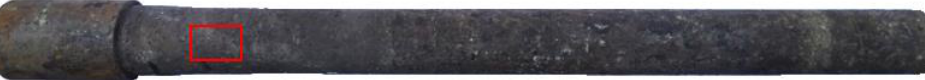
Figure 6. Sticking position of corrosion scales on the outer wall ( a ) and SEM images of corrosion stuck from the inner wall of tubing ( b ). The SEM images, as shown in Figure 7, demonstrate that the corrosion product films on the inner wall of tubing show a layered structure. The corrosion product layer is thick, and there are a lot of micro-cracks on the surface of the corrosion product films. CO 2 corrosion trace is found at high magnification, a small amount of FeCO 3 grains have obvious edges and corners, but most of the grains have edges and corners dissolved. In addition, a large number of irregular spherical particles can be seen attached to the corrosion product film.